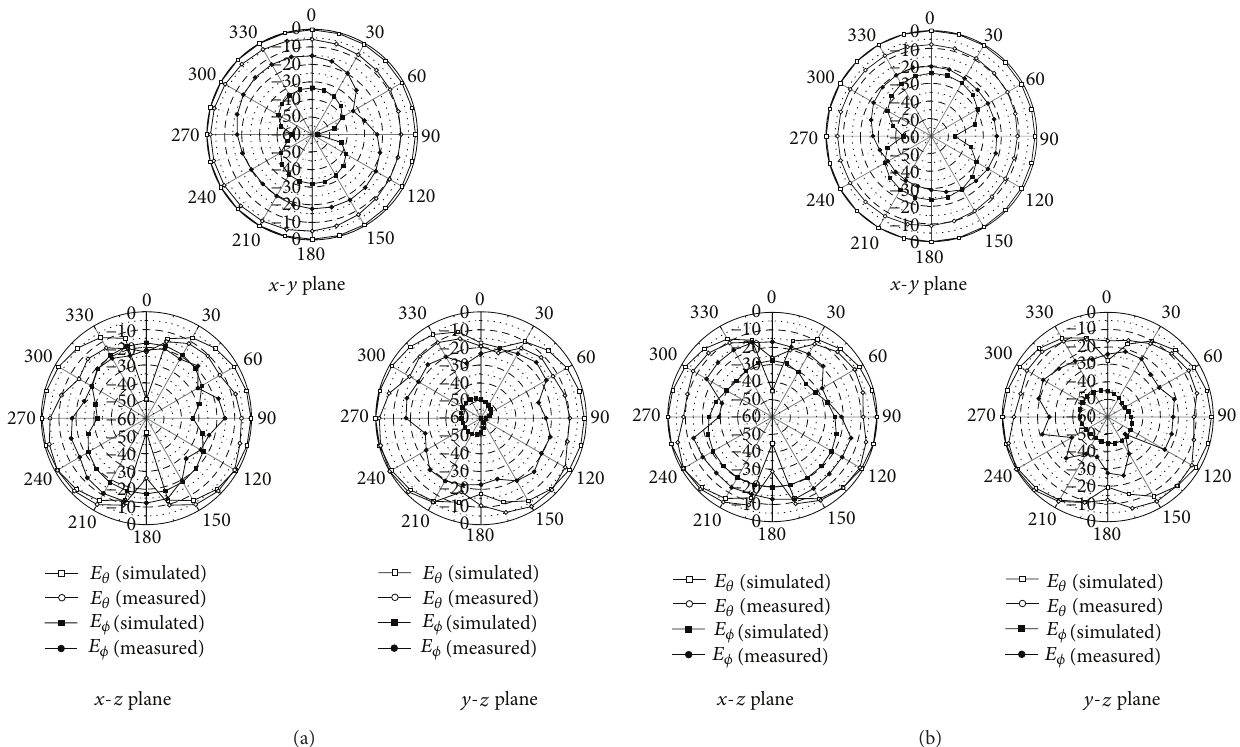
F 9: Simulated and measured 2D radiation patterns of proposed antenna: (a)